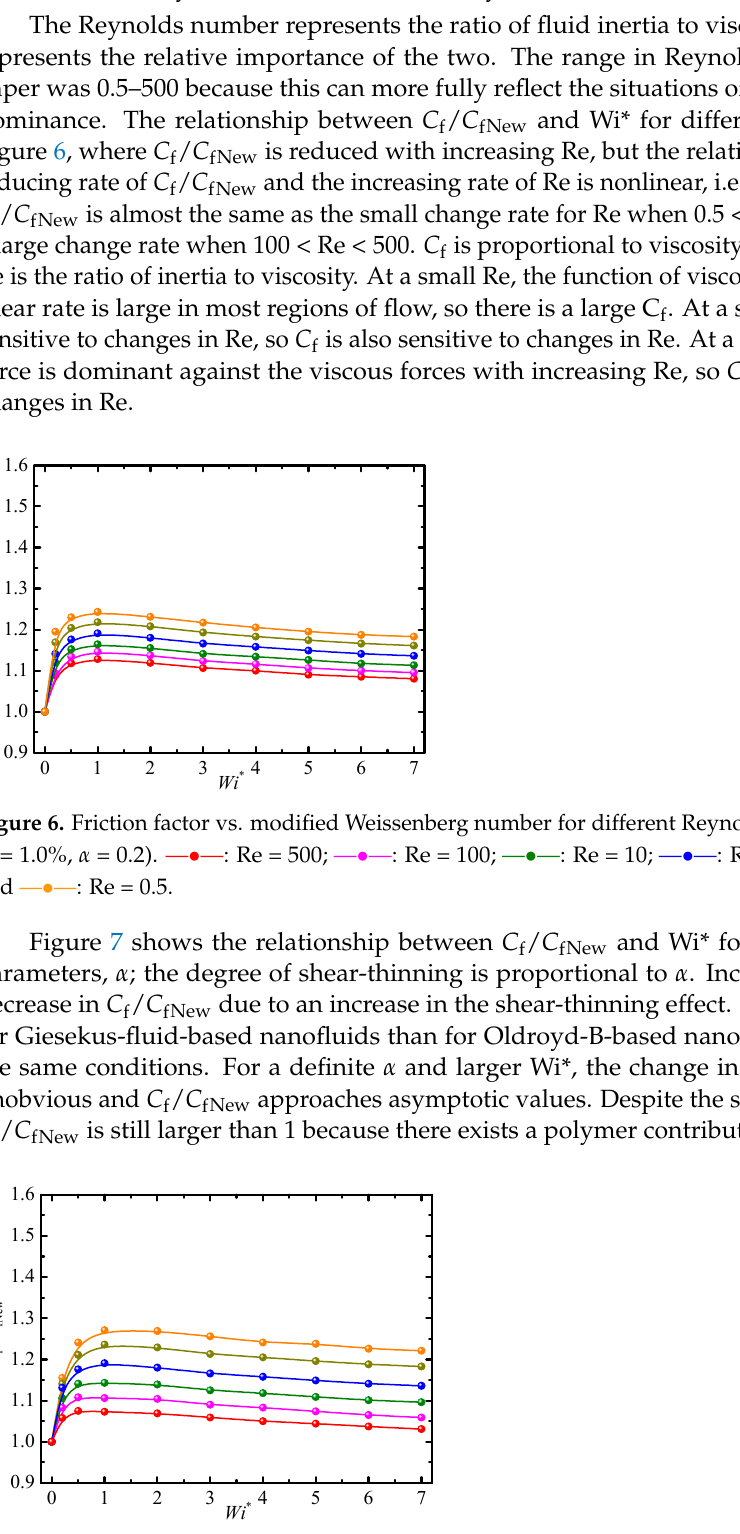
Figure 7. Friction factor vs. modified Weissenberg number for different mobility parameters (Re = 2.5, Φ = 1.0%, β 0 = 0.2). ⸺ ● ⸺ : α = 0.5; ⸺ ● ⸺ : α = 0.4; ⸺ ● ⸺ : α = 0.3; ⸺ ● ⸺ : α = 0.2; ⸺ ● ⸺ : α = 0.1; and ⸺ ● ⸺ : α = 0.